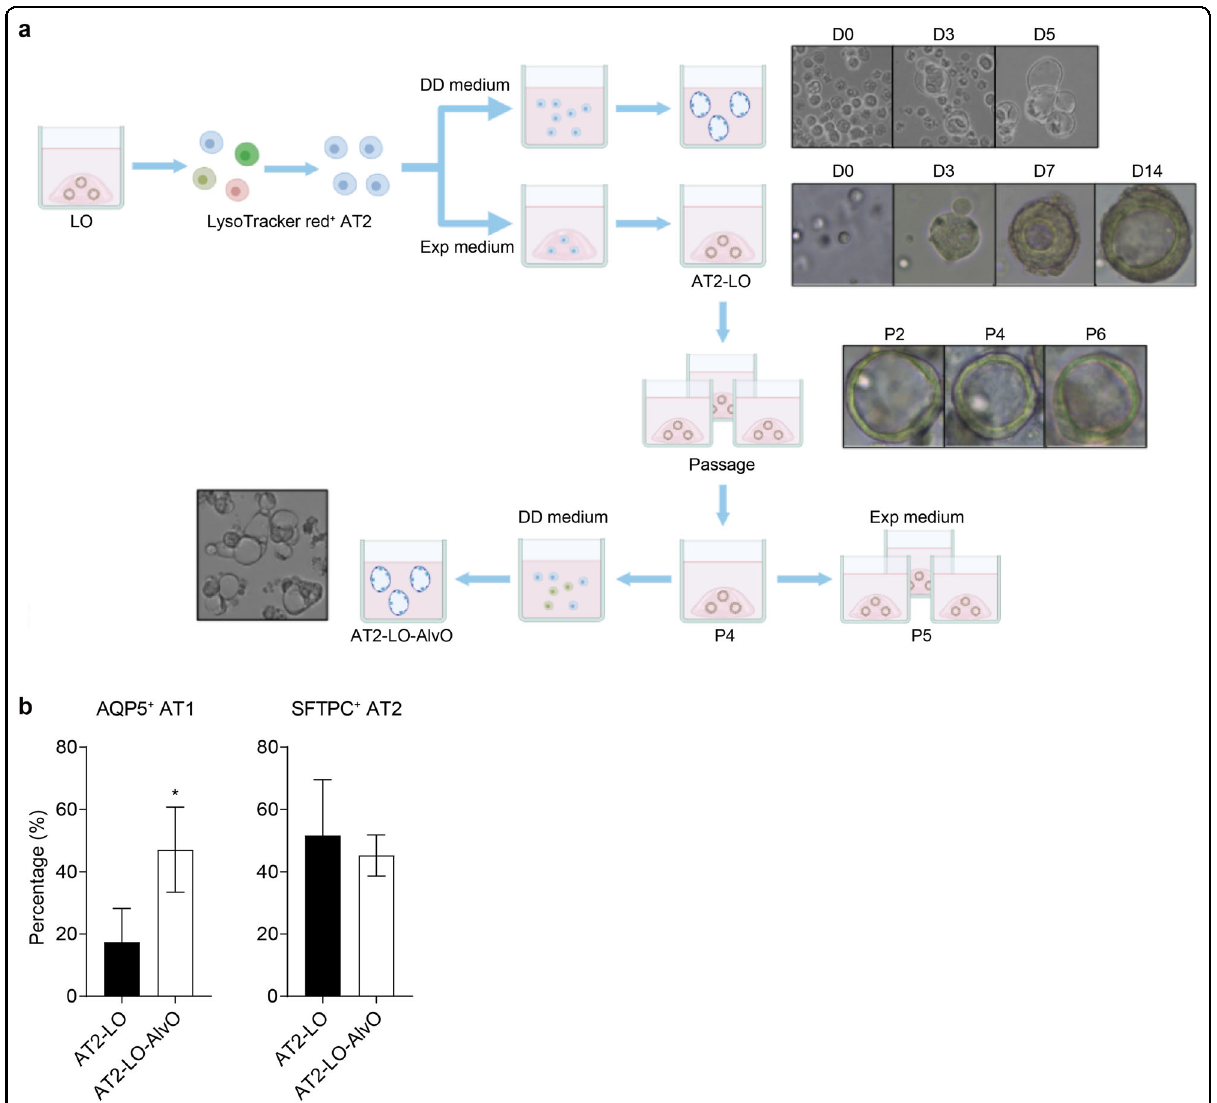
Fig. 2 Identi fi cation of AT2 cells as progenitor cells to derive alveolar organoids. a A schematic graph outlines the experimental procedure. Puri fi ed AT2 cells undergoing DD protocol developed cystic structures similar to AlvOs. Photomicrographs on day 0 (D0), day 3, and day 5 (magni fi cation 200×) are shown. Single AT2 cells 3D incubated in the expansion medium assumed a morphology similar to lung organoid (AT2-LO) during the 2-week culture. Photomicrographs show a growing organoid from day 0 to day 14 (magni fi cation 100×). AT2-LOs were consecutively passaged for 6 months. Photomicrographs show the organoids of a second (P2), fourth (P4), and sixth (P6) passage (magni fi cation 100×). AT2-LOs of the fourth passage subjected to DD protocol formed cystic AT2-LO-AlvOs on day 4 (magni fi cation 200×). b AT2-LOs of the fourth passage ( n = 4) and the derived AT2-LO-AlvOs ( n = 2) were applied to fl ow cytometry to examine the abundance of AT1 and AT2 cells. Data represent means ± SD of a representative experiment. Two-tailed unpaired Student ’ s t -test. See also Supplementary Fig.